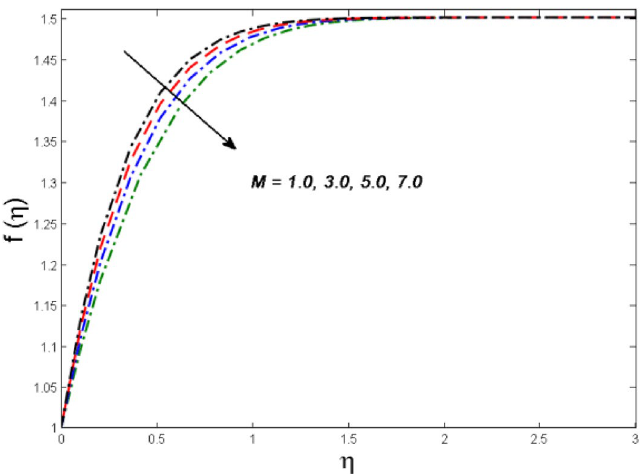
Figure 2. Impact of M on f (η) .